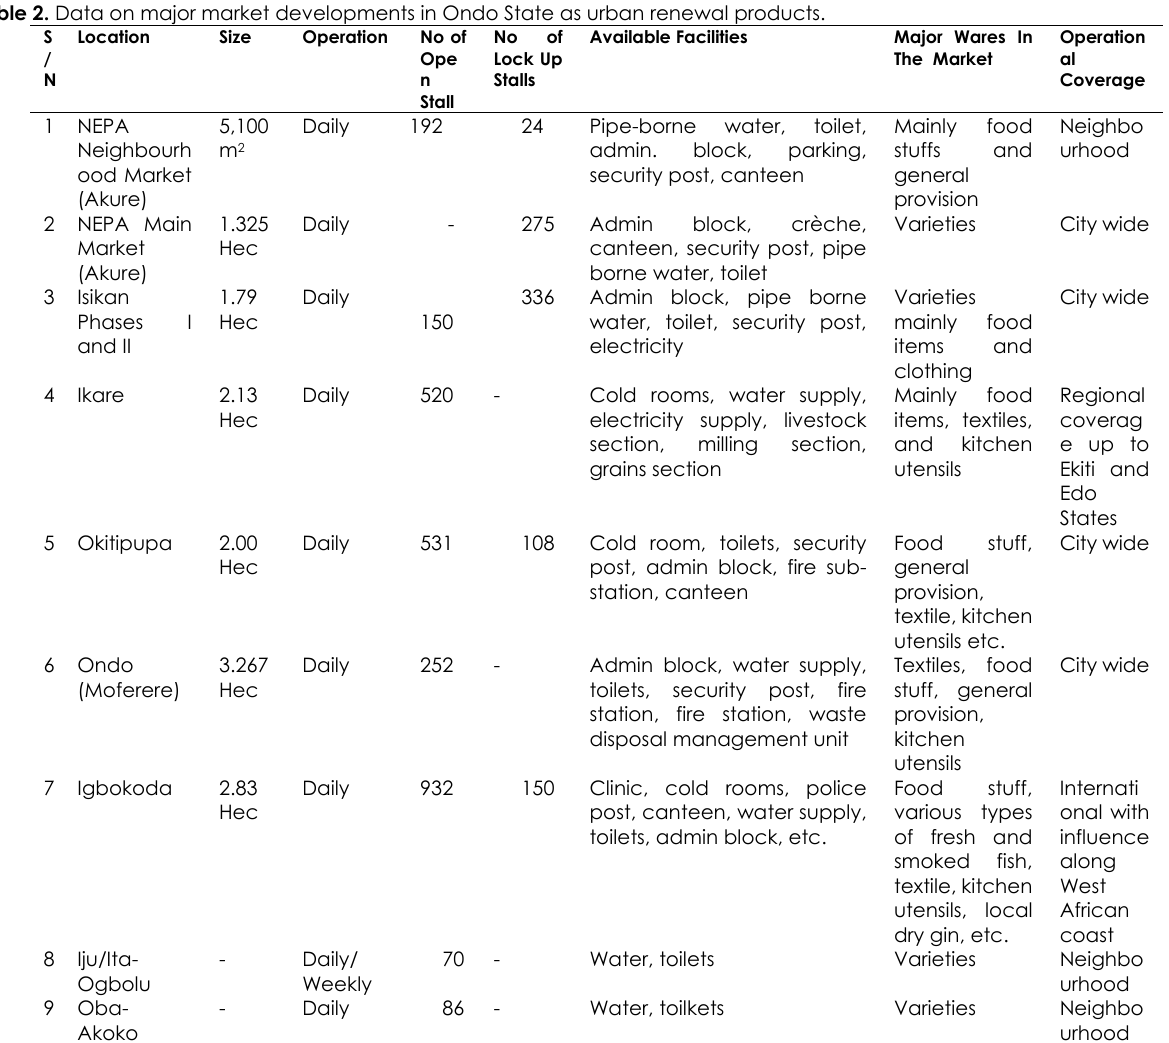
Table 2. Data on major market developments in Ondo State as urban renewal products.